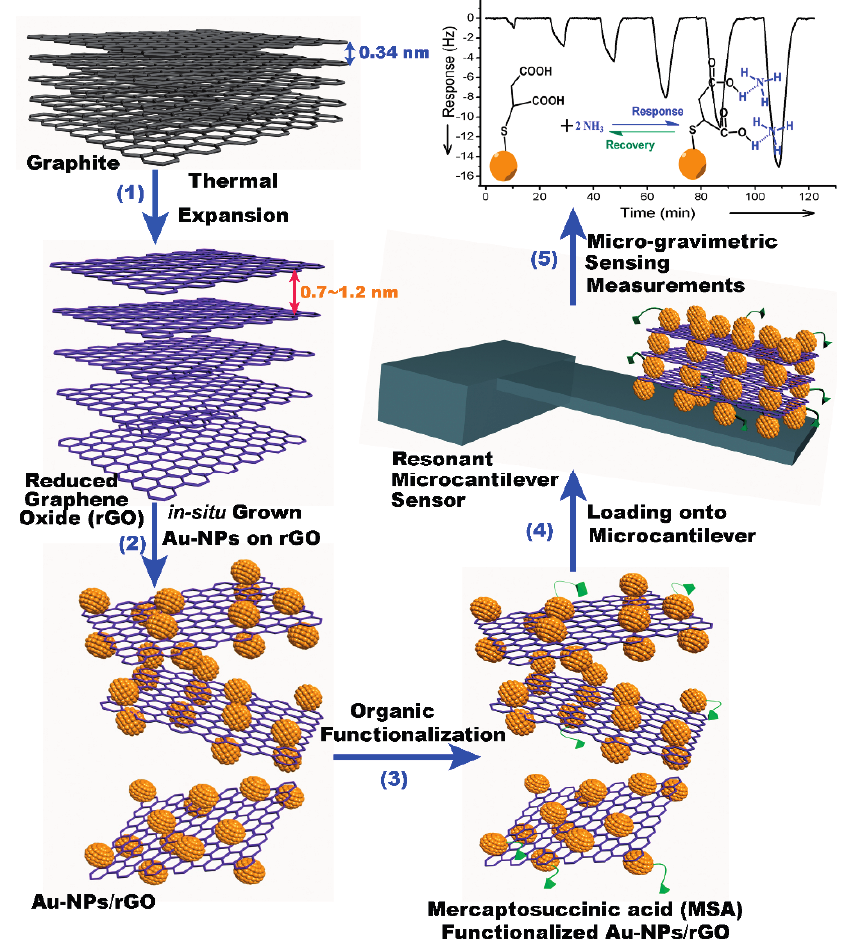
Figure 26. Schematic showing the process for preparing − COOH functionalized Au-NPs/rGO and constructing cantilever NH 3 sensor. Reprinted with permission from [114].